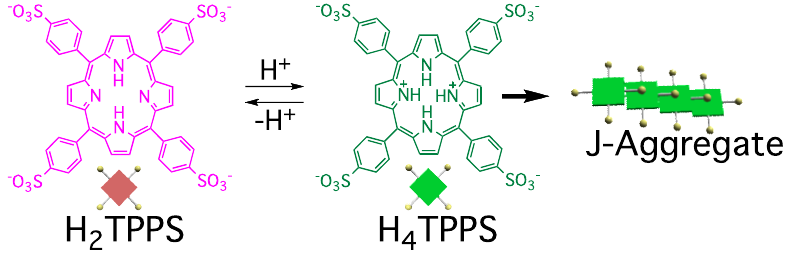
Figure 1. Molecular structure of TPPS and a schematic representation of its J-aggregate formation under acidic conditions.